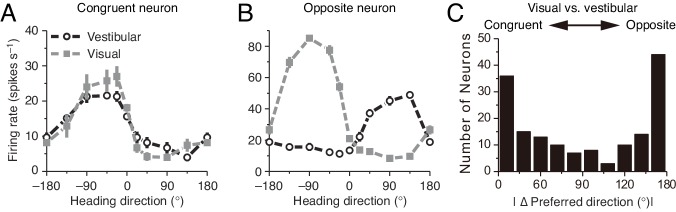
Congruent and opposite neurons in MSTd.Similar results were found in VIP (Chen et al., 2011). (A–B) Tuning curves of a congruent neuron (A) and an opposite neuron (B). The preferred visual and vestibular directions are similar in (A) but are nearly opposite by 180° in (B). (C) The histogram of neurons according to their difference between preferred visual and vestibular directions. Congruent and opposite neurons are comparable in numbers. (A–B) are adapted from Gu et al. (2008), (C) from Gu et al. (2006).